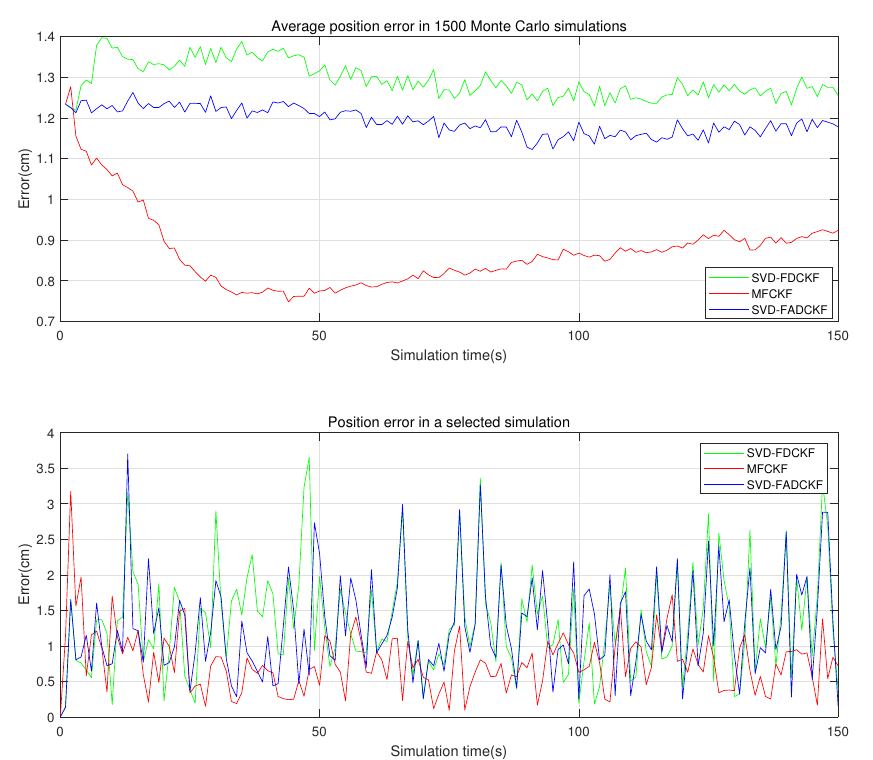
Figure 7. Positioning errors of the three